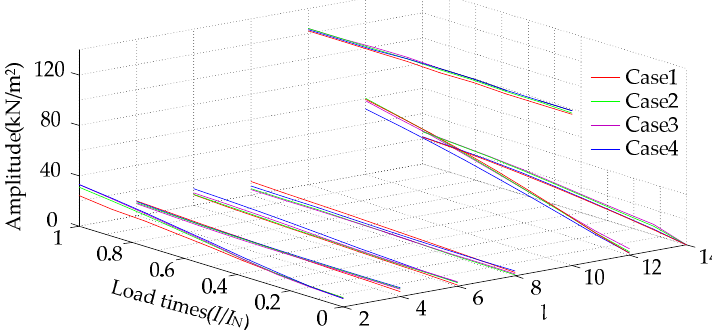
Figure 4. The amplitude curve of the radial electromagnetic force in the air gap with the load times (3D diagrams).